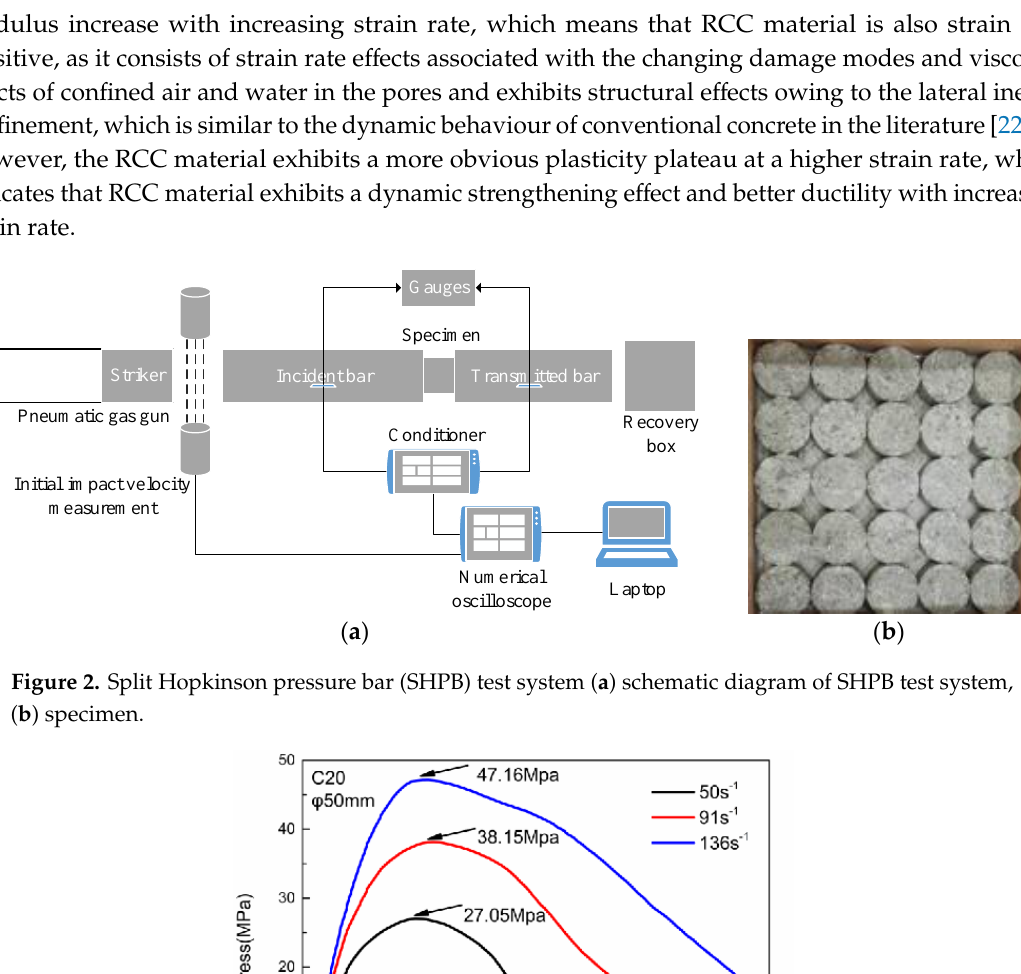
Figure 2. Split Hopkinson pressure bar (SHPB) test system ( a ) schematic diagram of SHPB test system, ( b ) specimen.